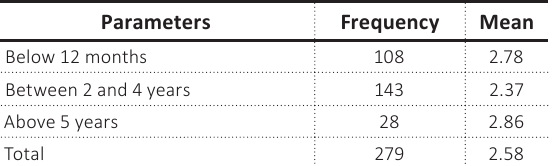
Table 7. EFD use experience and tax compliance –